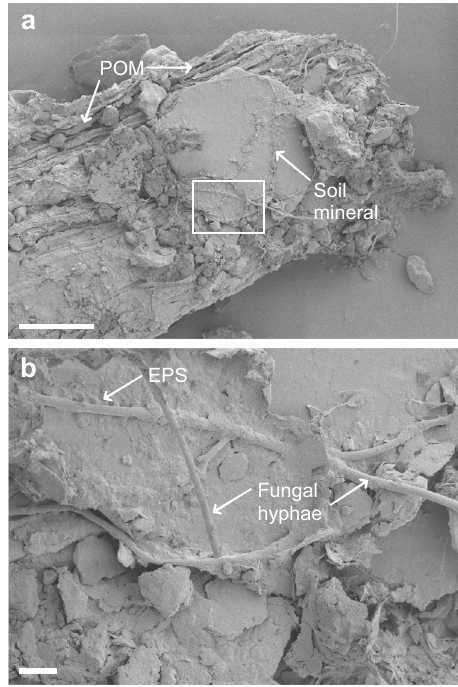
Fig. 6 SEM micrographs of the spatial connection of organo-mineral assemblages. Scanning electron microscopy (SEM) images of the interface of plant litter (POM) and soil minerals, where soil minerals are ( a ) attached to the litter surface (scale bar = 100 µ m) and ( b ) enmeshed with fungal hyphae and extracellular polymeric substances (EPS; scale bar = 10 µ m). Similar images were obtained from at least 10 independent locations in each soil